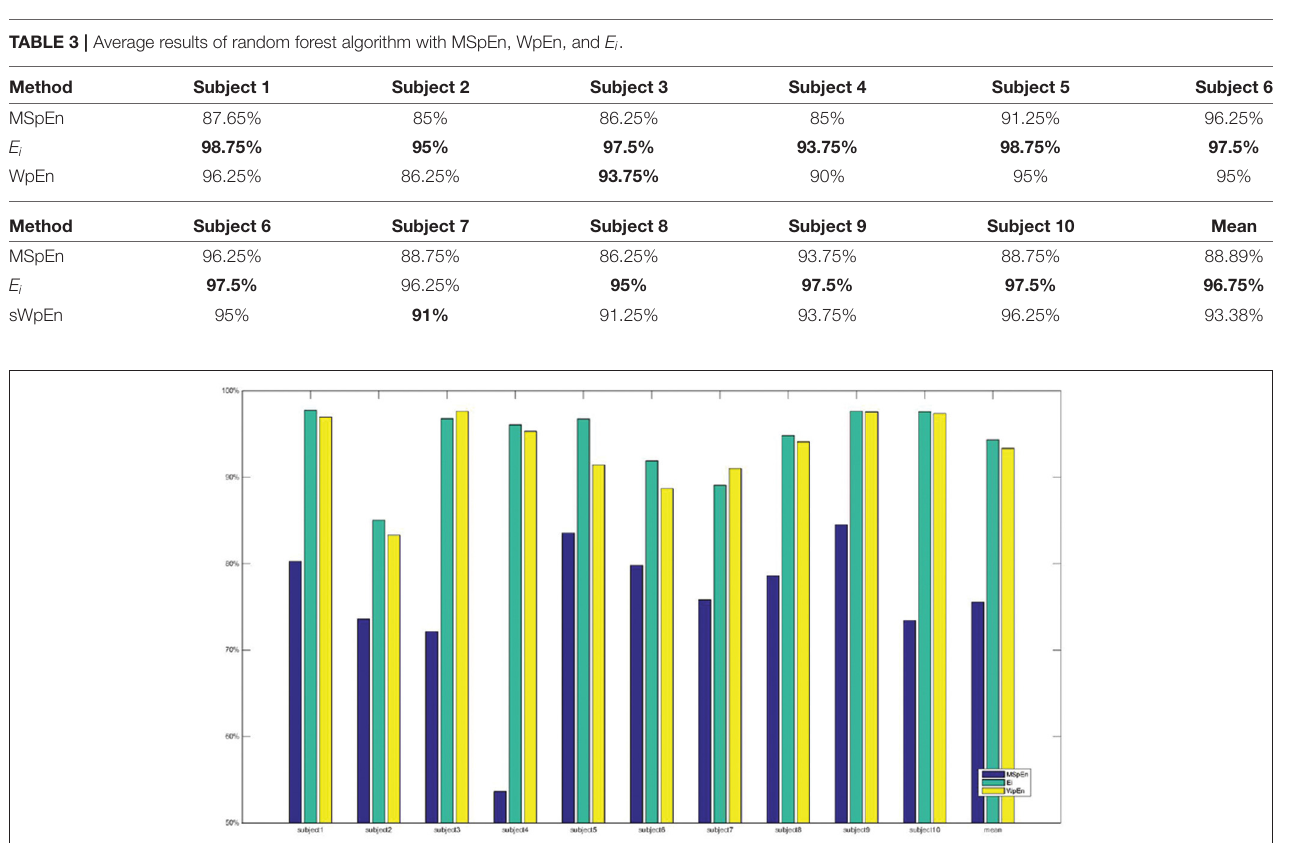
TABLE 3 | Average results of random forest algorithm with MSpEn, WpEn, and E i .